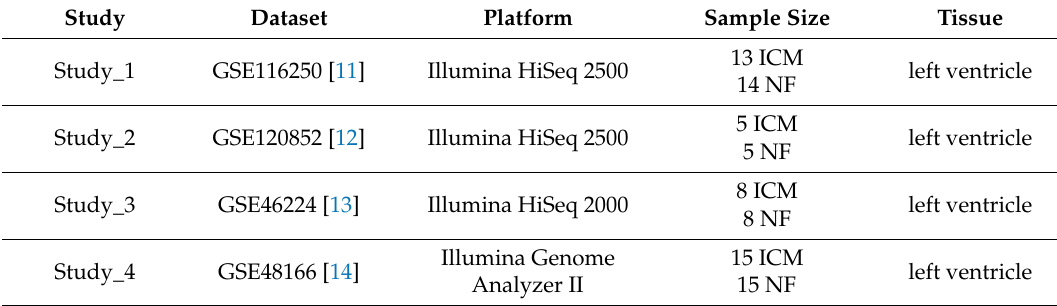
Table 1. GEO datasets used for